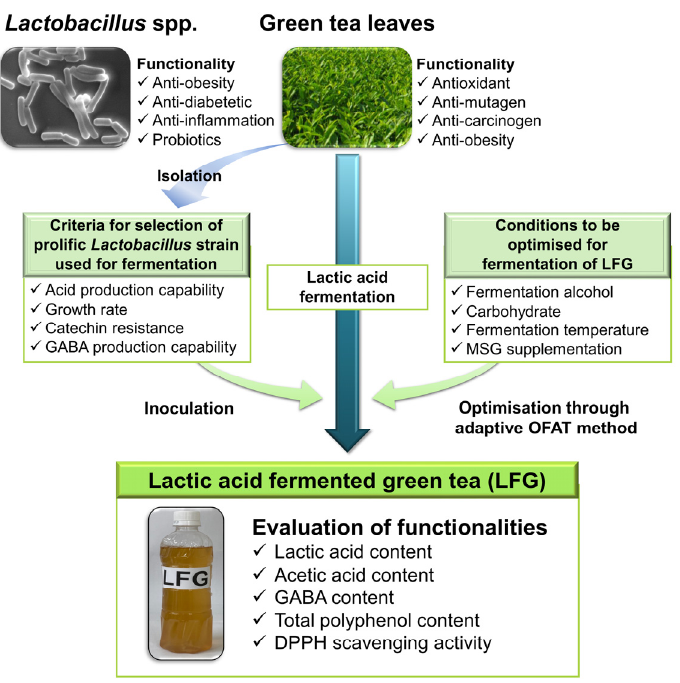
Figure 1. Conceptual scheme of LFG fermentation with a GABA-producing Lactobacillus strain under optimised fermentation conditions.